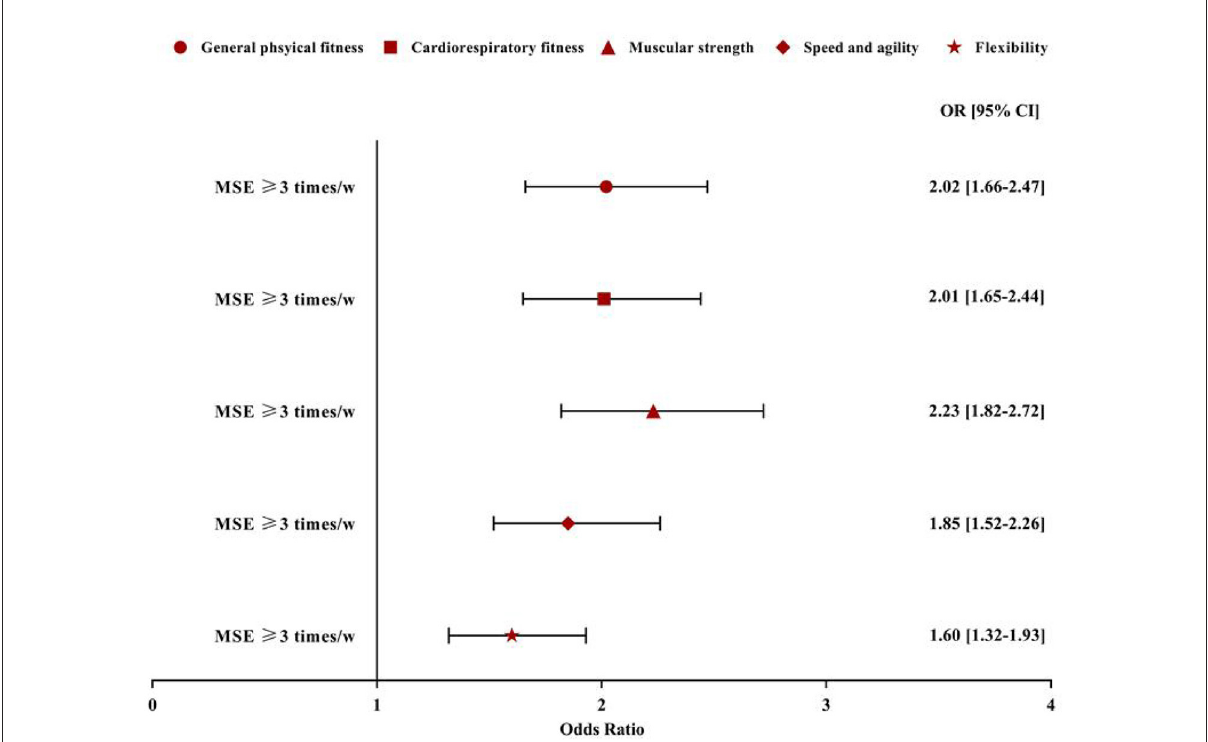
FIGURE3 Association between muscle strengthening exercise and self-reported health-related physical fitness indicators. Model controlled for age, sex, siblings, living with parents or not, grade, residence, father and mother education level, and perceived family affluence, moderate to vigorous physical activity, recreational screen time and sleep duration. MSE, muscle-strengthening exercise; w, week; OR, odd ratio; CI, confidence interval. Reference group: no more than 3